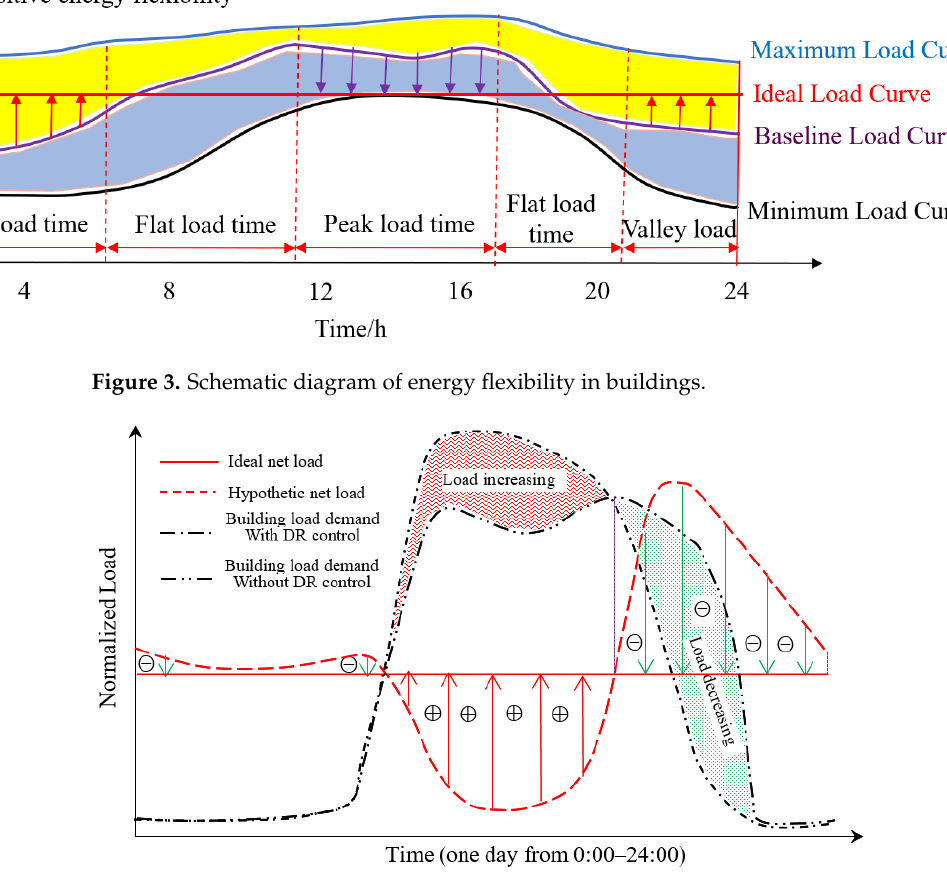
Figure 4. Schematic diagram of the load management of different DR strategies.